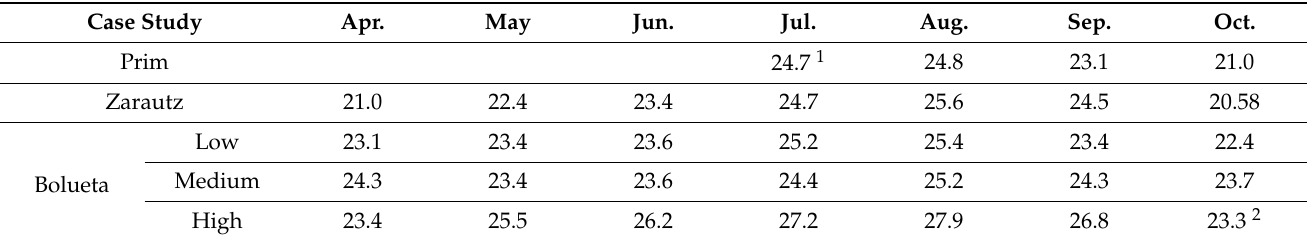
Table 6. Average monthly temperatures ( ◦ C), April–October 2020.